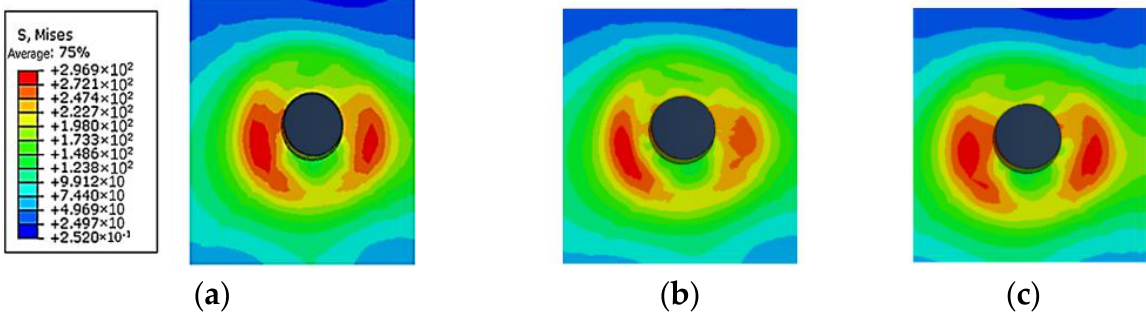
Figure 11. Mises stress distribution of sheet under maximum tensile load: ( a ) spacing is 4 times the diameter; ( b ) increase the spacing by 2 mm (OSI); ( c ) decrease the spacing by 2 mm (OSD).